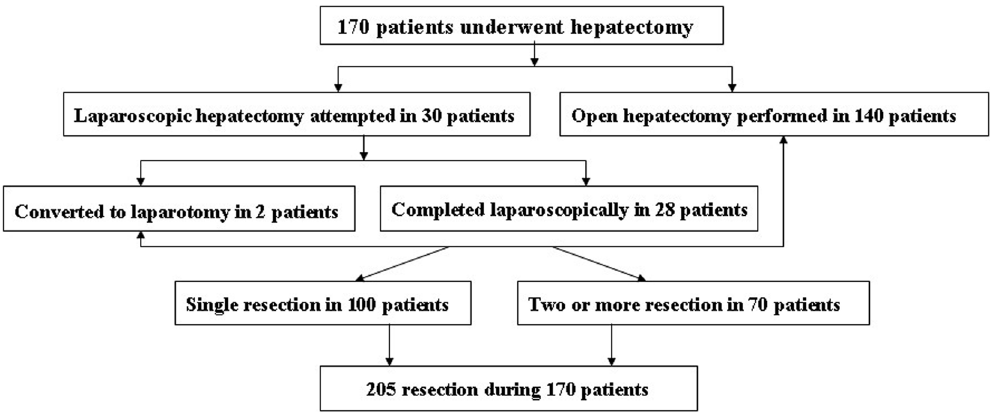
Figure 1. Flow chart of attempted hepatectomy.